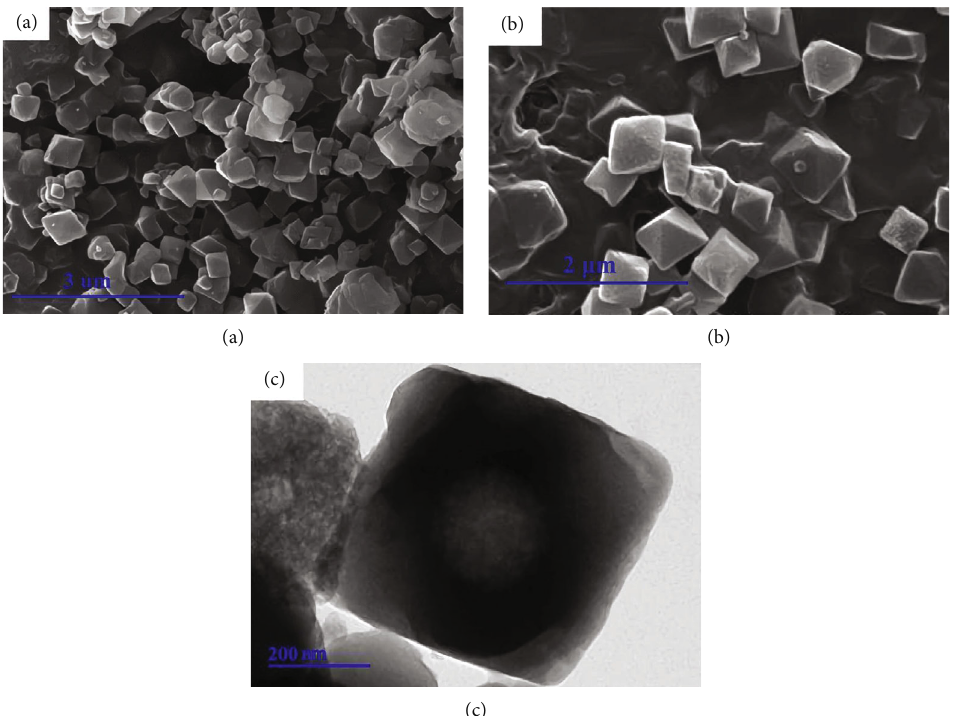
Figure 2: (a) The SEM photograph of the MIL-101. (b) The SEM photograph of the etched MIL-101. (c) The TEM photograph of the etched MIL-101.